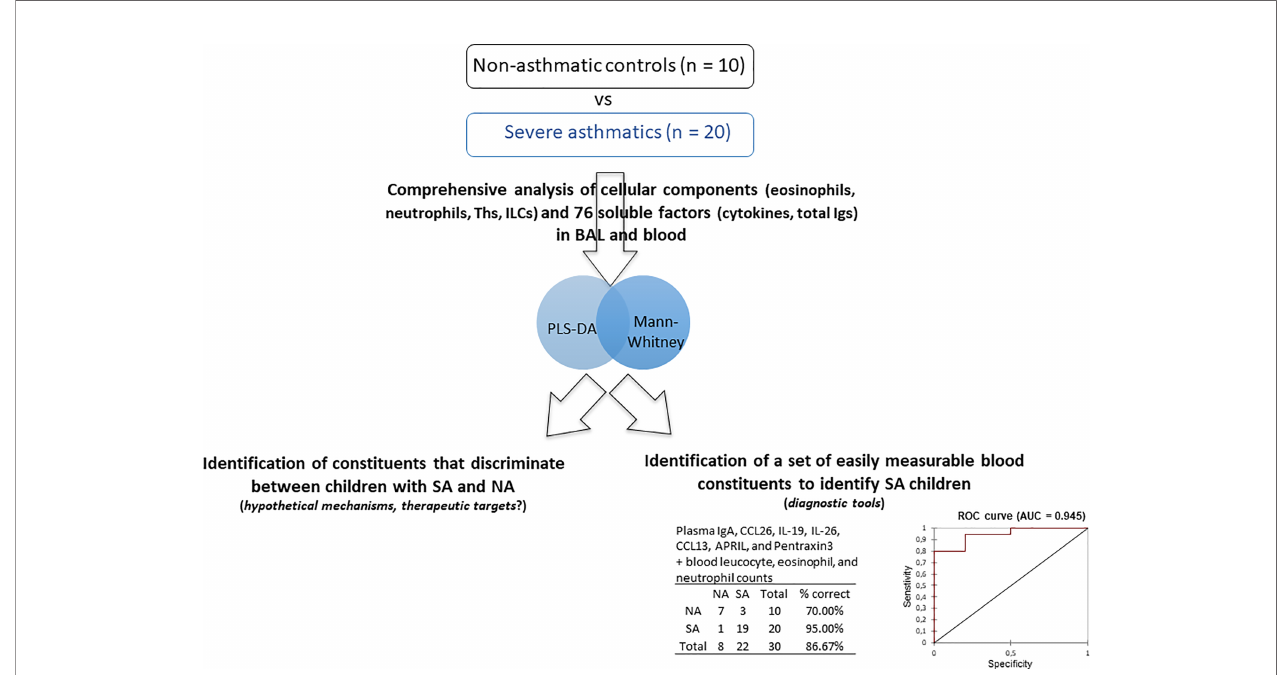
FIGURE 4 | Preliminary analysis to de fi ne a set of blood parameters that allow discrimination between children with SA and disease-control children. This model is biased, as the same cohort and parameters used to construct the initial PLS-DA were used to identify the discriminant variables. These results will need to be con fi rmed on an independent validation